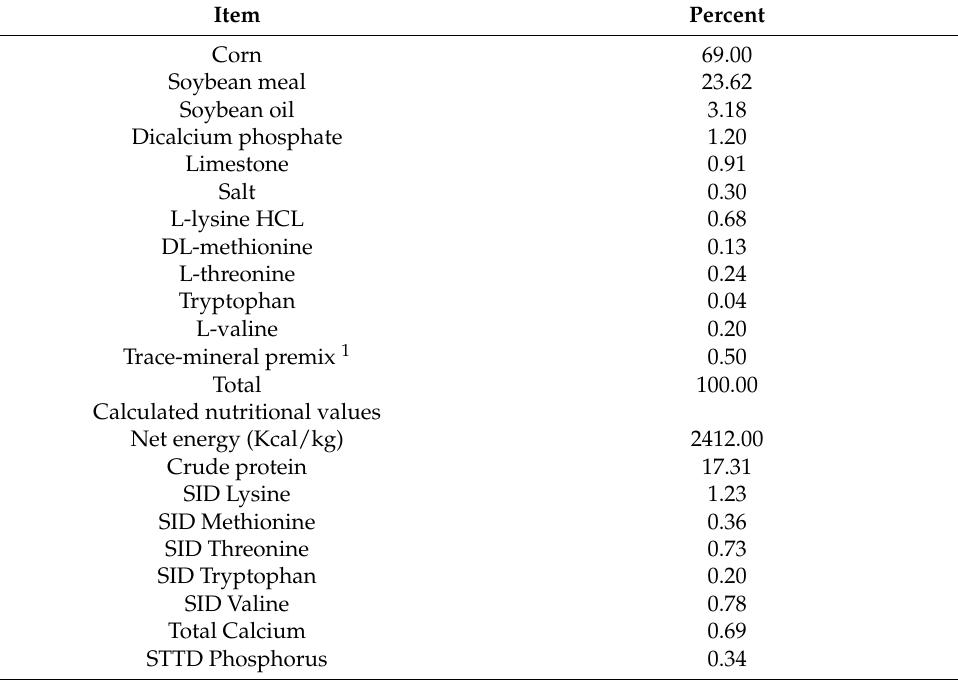
Table 1. Ingredient composition of the experimental diet (%, as-fed basis). Item